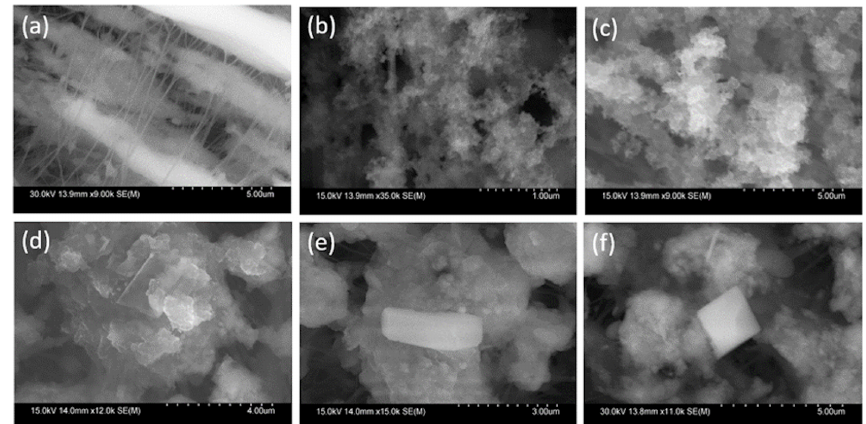
Figure 7. Scanning electron microscope (SEM) images of (a) a blank PTFE (Teflon) substrate and (b–f) particles in different diameter ranges with firework influence: (b) 0.1–0.18µm, (c) 0.18–0.32µm, (d) 0.32–0.56µm, and (e–f)